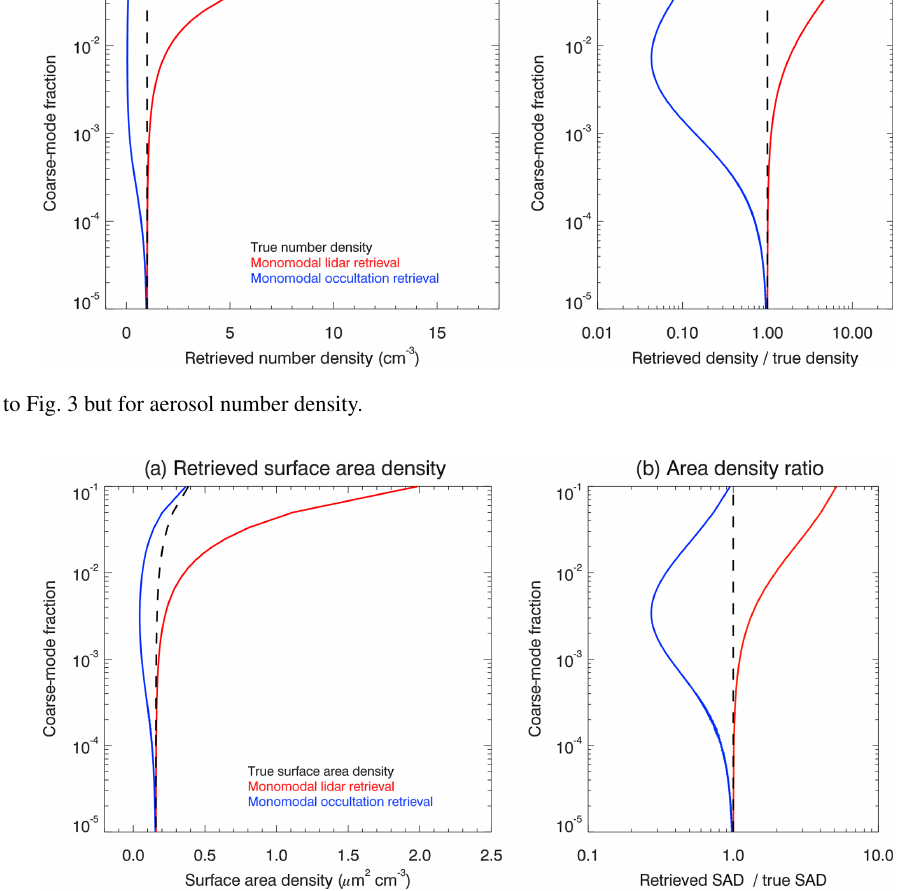
Figure 7. Similar to Fig. 3 but for surface area